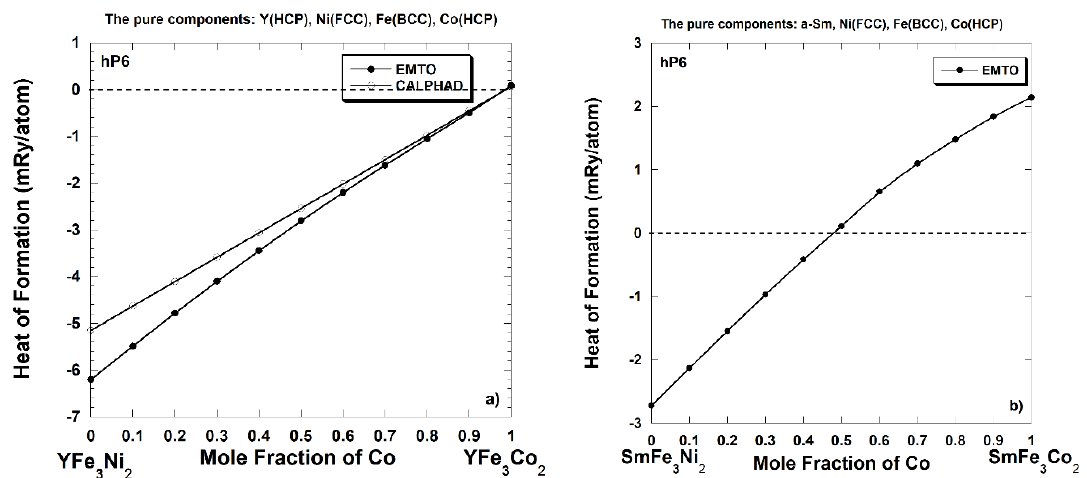
Figure 2. ( a ) The heat of formation of the pseudo-binary YFe 3 (Ni 1-x Co x ) 2 alloys predicted via ab initio (0 K) and CALculation of PHAse Diagrams (CALPHAD) (298 K) calculations. ( b ) The heat of formation of the pseudo-binary SmFe 3 (Ni 1-x Co x ) 2 alloys predicted via ab initio calculations [4].